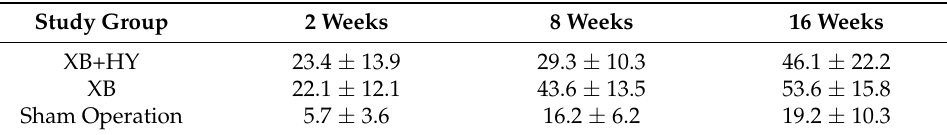
Table 5. Amounts of newly formed bone tissue in the different study groups and at the three study time points (in %).